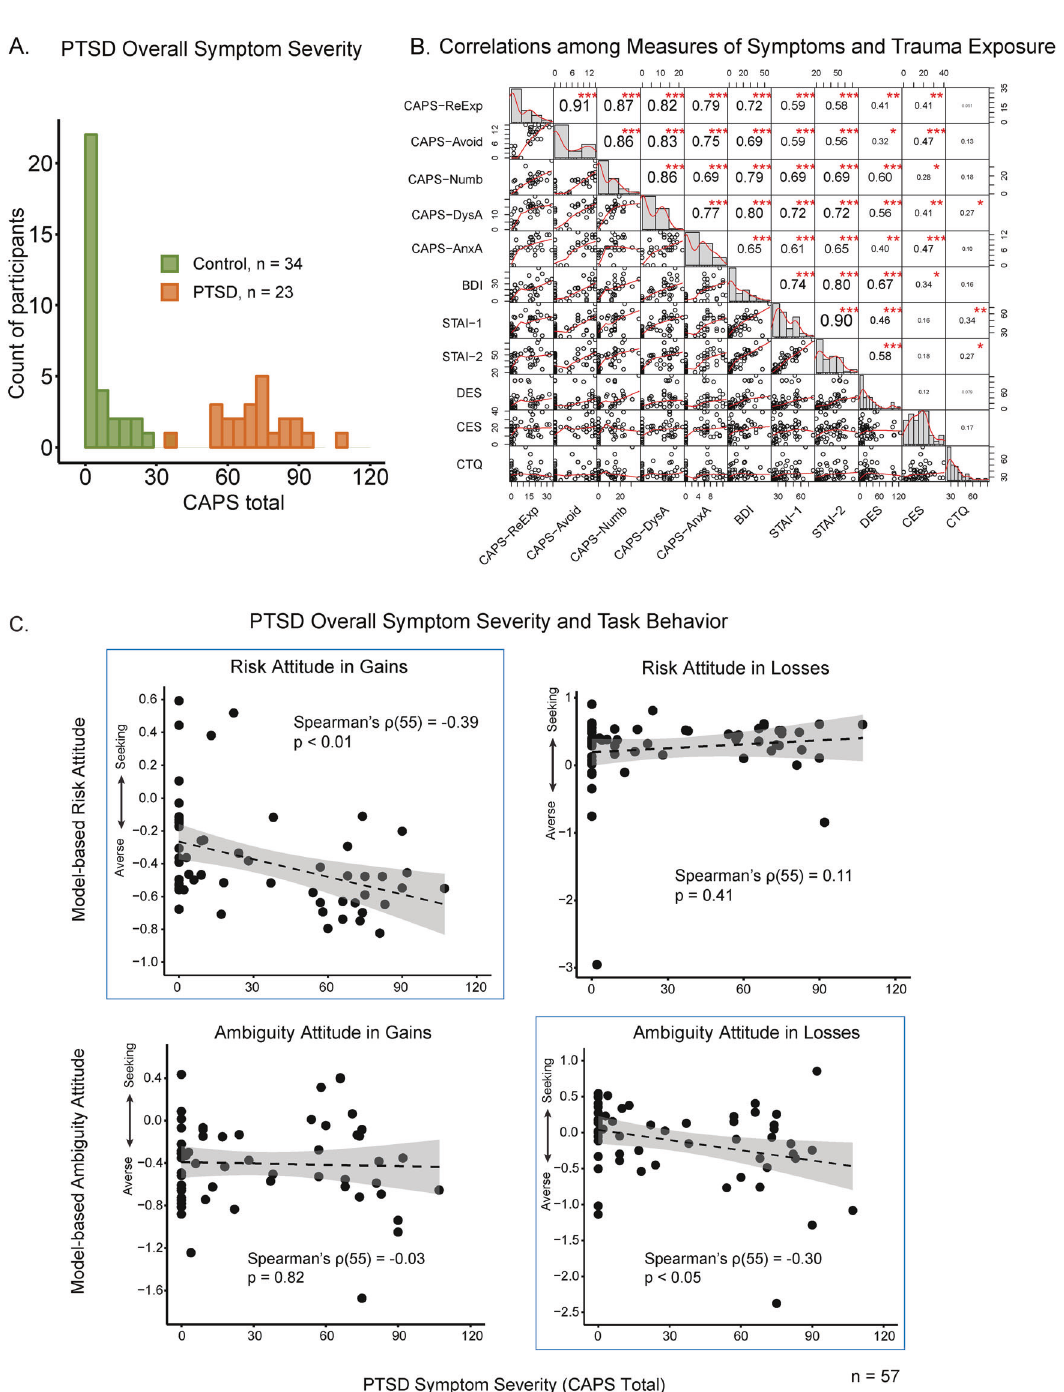
Fig. 2 Participants ’ symptom severity and behavior. A Distribution of CAPS total score of participants included in the behavioral analysis, colored by group (combat veterans with or without PTSD diagnoses). One PTSD participant included in the analysis did not have complete CAPS data. B PTSD, depression and anxiety symptom severities were highly correlated. Numbers in the upper right panels indicate pair-wise Pearson correlation coef fi cients. Signi fi cance levels: *** p < 0.001; ** p < 0.01; * p < 0.05. Lower left panels show pairwise scatter plots and smoothed curves using locally weighted polynomial regression. Panels in the diagonal show distributions and density curves for each measure. Labels of measures: CAPS-ReExp: re-experiencing, CAPS-Avoid avoidance, CAPS-Numb numbing, CAPS-DysA dysphoric arousal, CAPS-AnxA anxious arousal, BDI Beck Depression Inventory, STAI-1 State Anxiety, STAI-2 Trait Anxiety, DES Dissociative Experiences Scale, CES Combat Exposure Scale, CTQ Childhood Trauma Questionnaire. C Correlation between overall PTSD symptom severity (CAPS total) and attitudes under four decision conditions. PTSD symptom severity was negatively correlated with ambiguity attitude in losses and risk attitude in gains. One participant was not included in the analysis due to missing CAPS. All attitudes were transformed such that negative numbers indicate aversion to risk or ambiguity, and positive numbers indicate